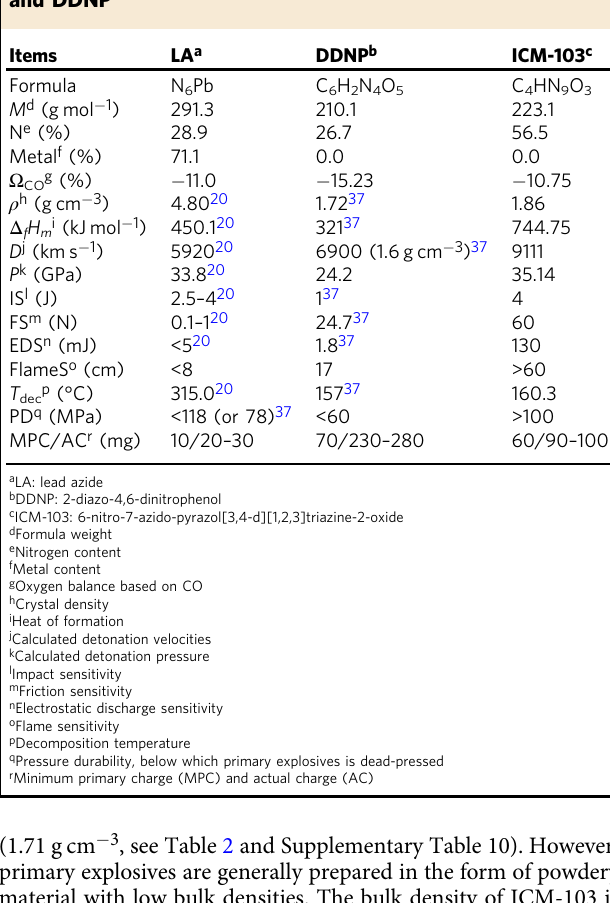
Table 2 Physical and detonation properties of ICM-103,